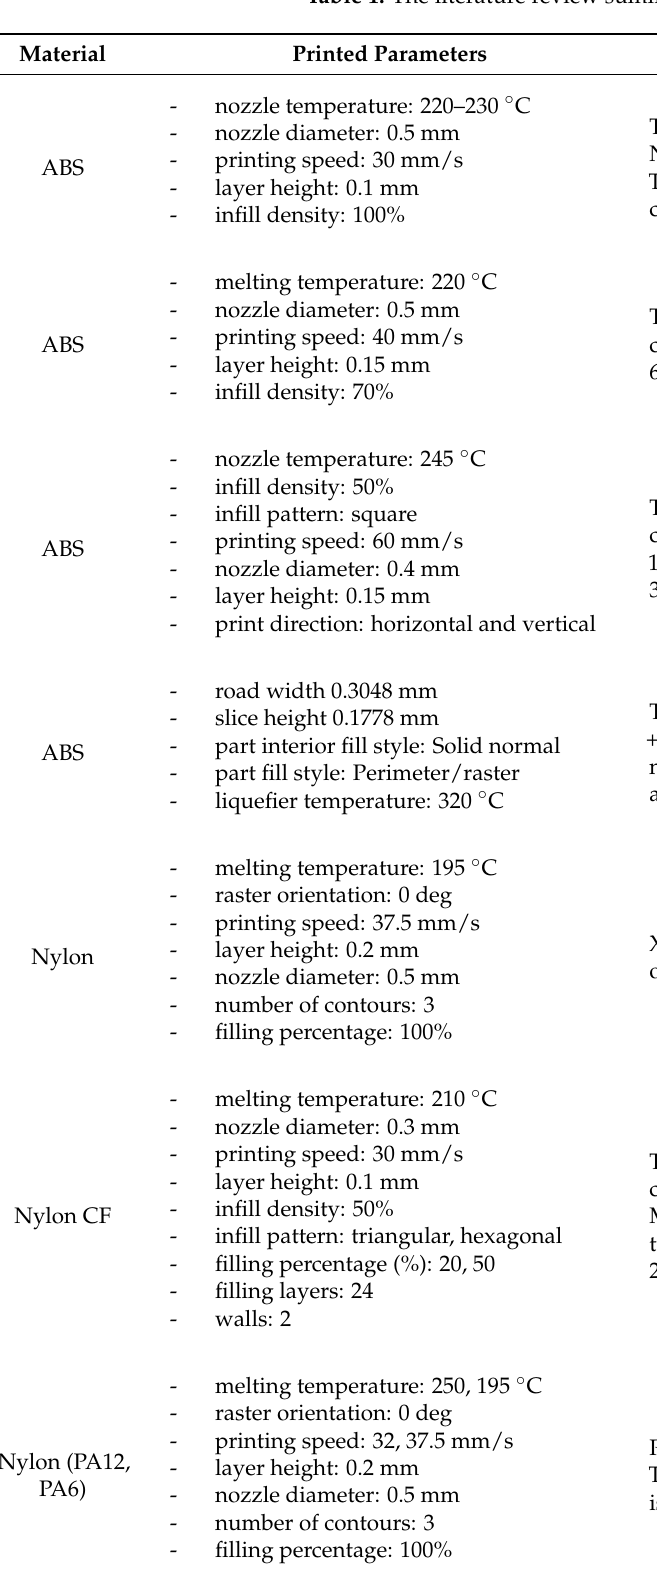
Table 1. The literature review